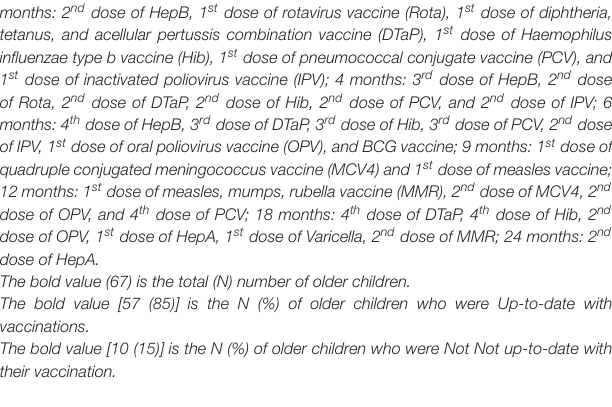
dose of HepA. The bold value (67) is the total (N) number of older children. The bold value [57 (85)] is the N (%) of older children who were Up-to-date with vaccinations. The bold value [10 (15)] is the N (%) of older children who were Not Not up-to-date with their